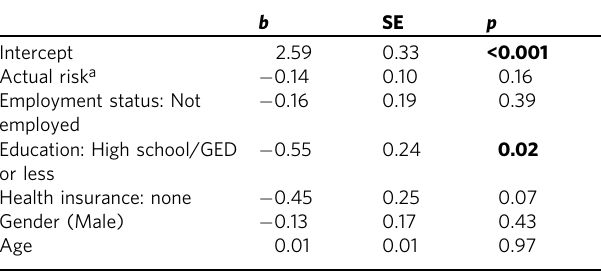
Table 4 Generalized linear models predicting the association between perception of risk of COVID-19 to one ’ s